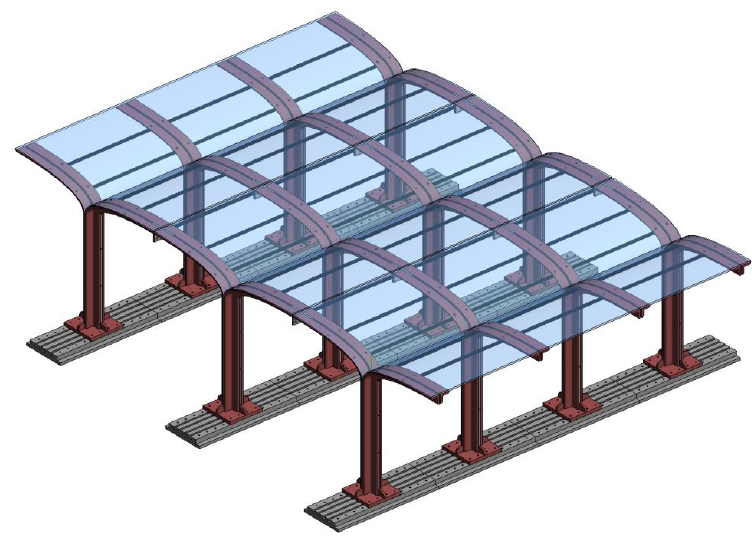
Figure 17. Spatial form of a linearly extended basic unit.